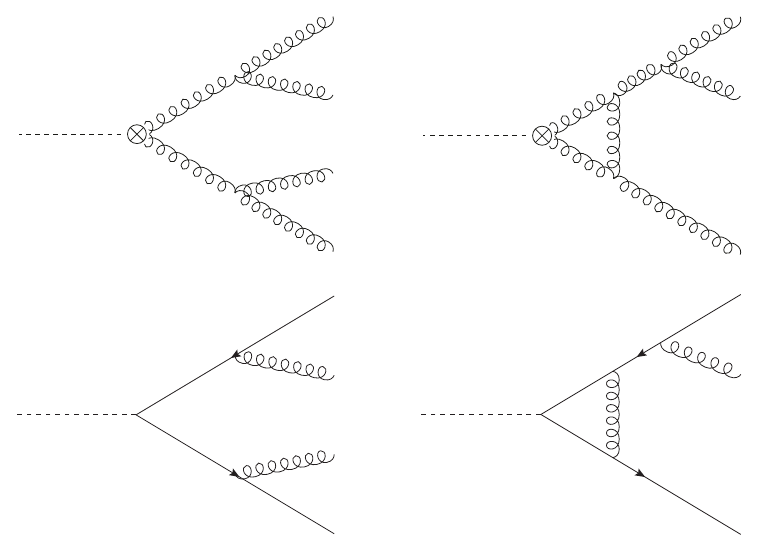
Figure 3 . Representative Feynman diagrams for the Hgg channel (upper) and the Hq (cid:22) q channel (lower) at